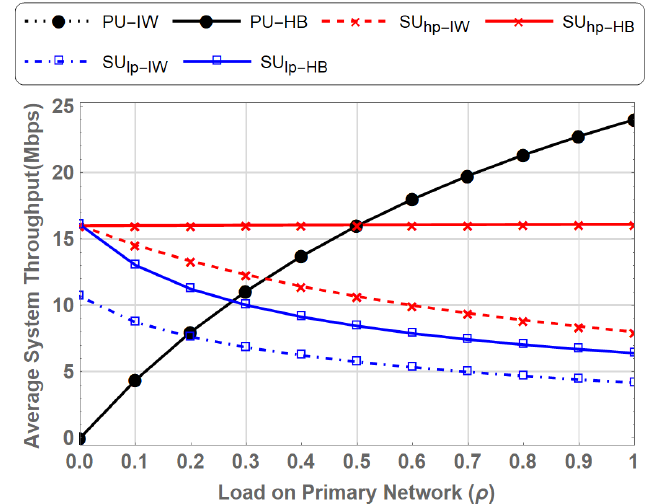
Figure 16. Comparison of Average System Throughput for PN-MC-IW and